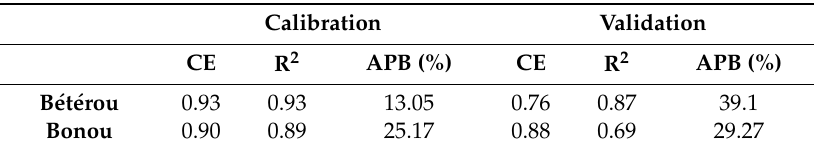
Figure 8. Observed and simulated mean hydrographs for Bétérou ( top ) and Bonou ( bottom ) catchments for calibration and validation periods. Table 2. Performance criteria of the hydrological model based on the least action principle (HyMoLAP) for the Bétérou and Bonou catchments, of the Oueme River.